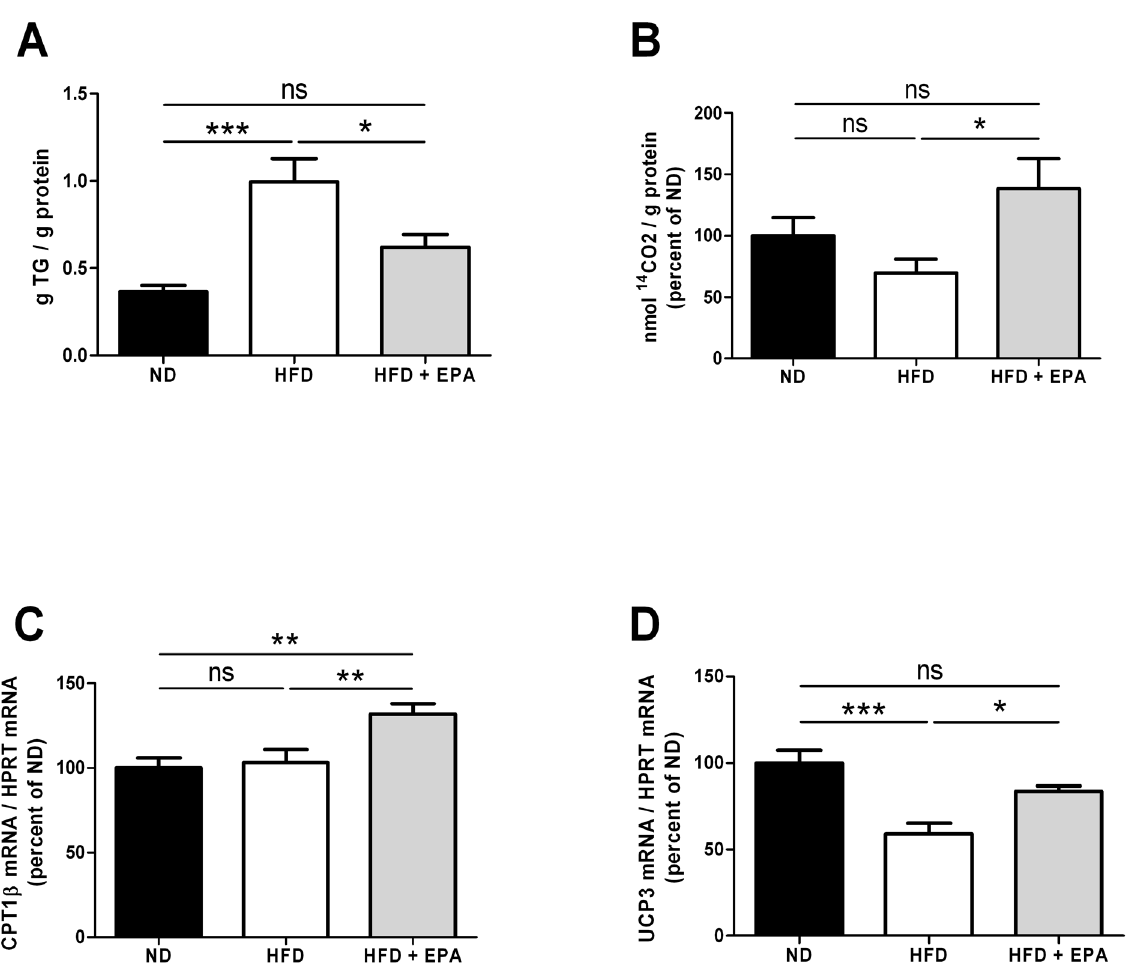
Figure 5. Effect of EPA on muscle lipid metabolism. (A) Intramuscular triglycerides content in red gastrocnemius of ND (n=9), HFD (n=10) and HFD + EPA (n=10) mice. (B) 14 C-palmitate complete b -oxidation and mRNA expression of (C) CPT1b and (D) UCP3 in soleus muscle of ND (n=9), HFD (n=6–10) and HFD + EPA mice (n=6–10). Results are mean 6 SEM and were normalized to the ND group (100%) for B, C and D, *p , 0.05, **p , 0.01, ***p ,